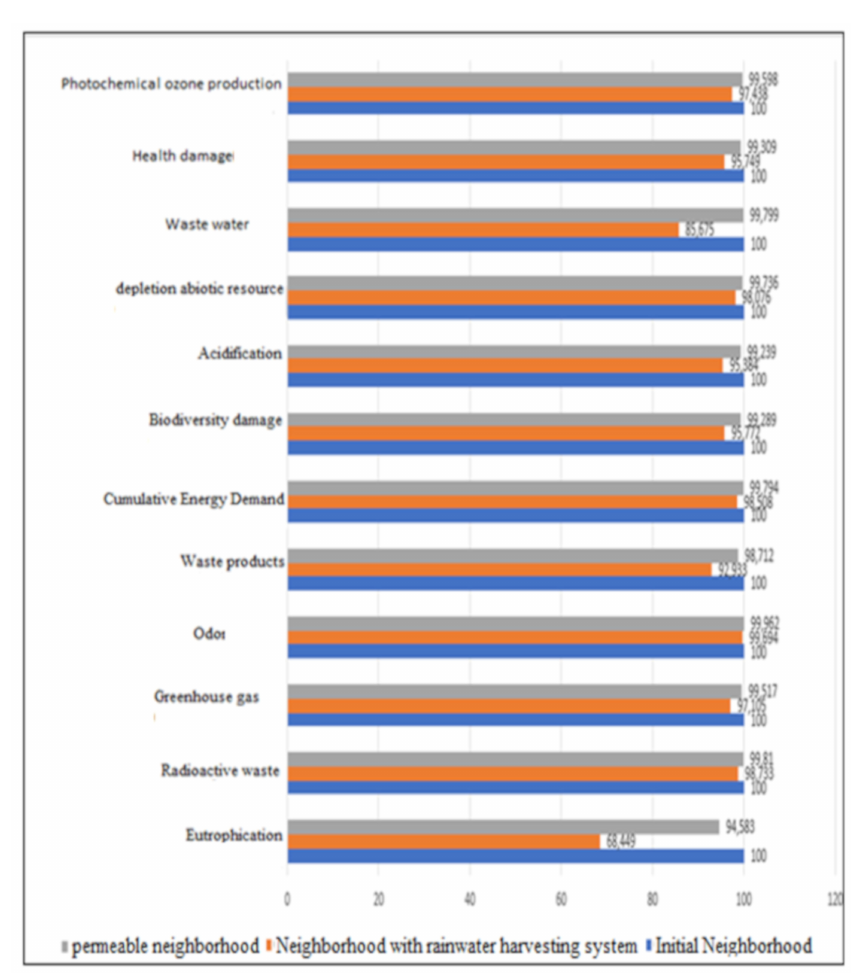
Figure 10. Comparative diagram of the environmental impacts of the initial scenarios, with and without permeable floor coverings (functional unit: entire neighborhood), in